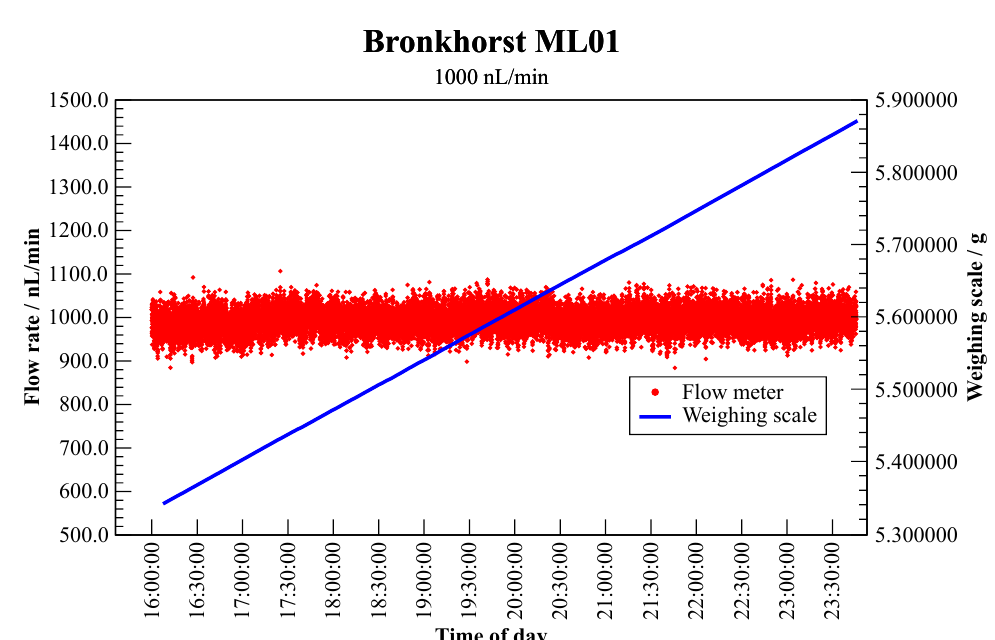
Figure 10. Measurement results of the Bronkhorst flow meter for a set flow rate of 1000nLmin − 1 . The red dots show the high-resolution (10Hz) flow rate values from the Bronkhorst flow meter (DUT) and the blue curve shows the mass increase recorded by the weighing scale (1Hz) in the same time frame.